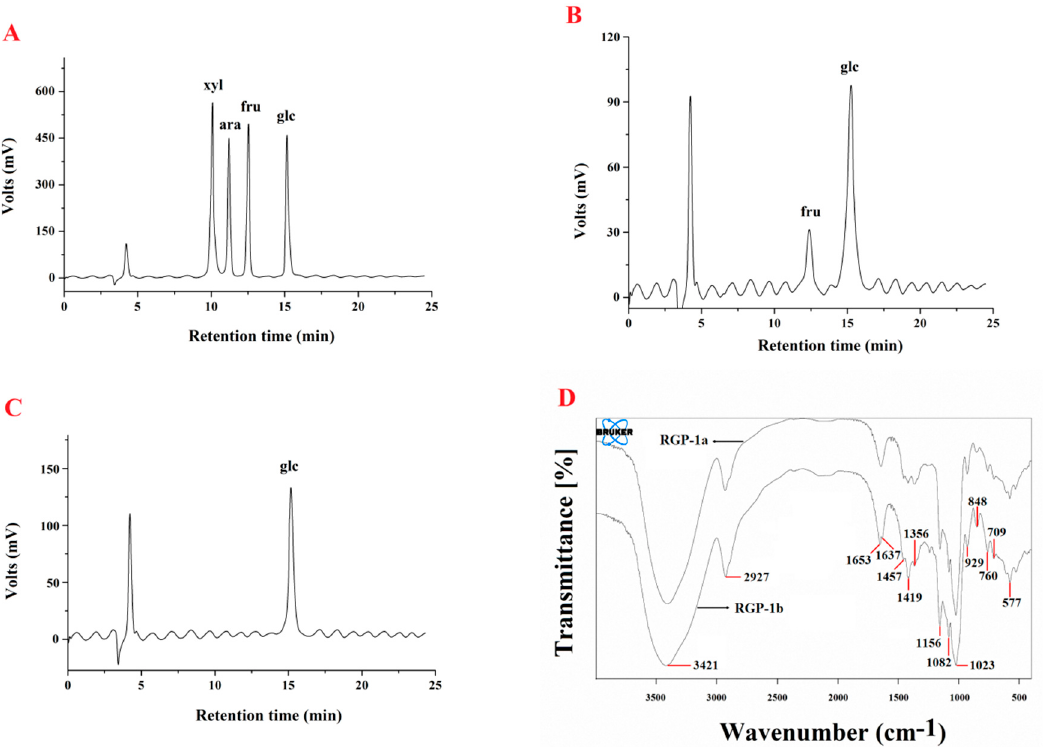
Figure 3. ( A ) HPLC spectra of standard monosaccharide; ( B ) RGP-1a; ( C ) RGP-1b and ( D ) FTIR spectra of RGP.